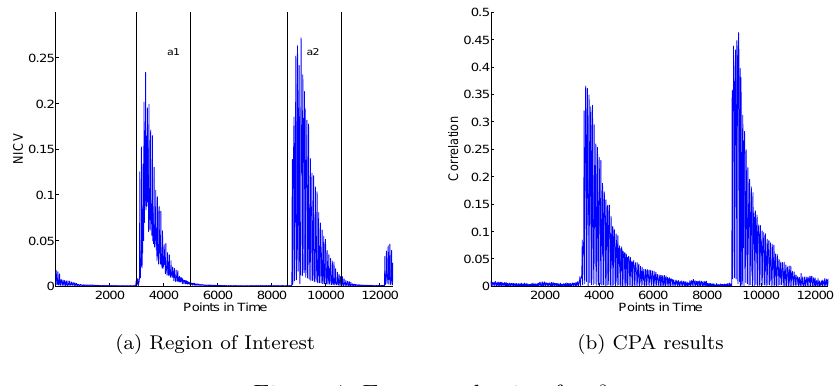
Figure 4: Feature selection for β